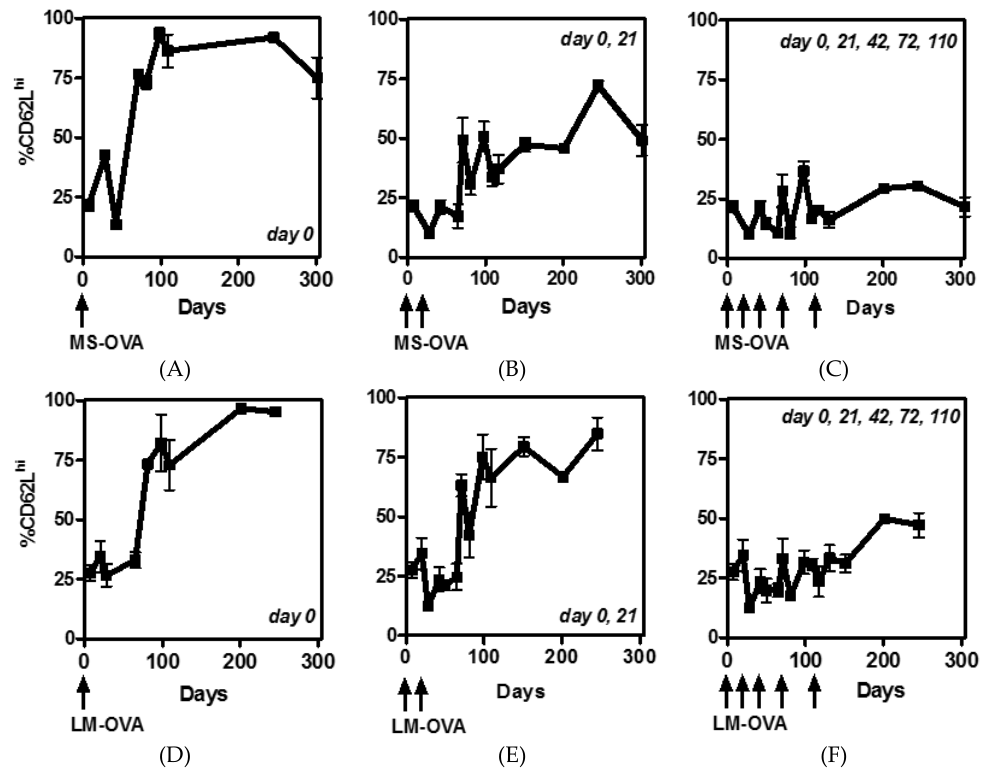
Figure 2. CD62L high expression on responding CD8 + T cells following prime-boost vaccinations with MS-OVA or LM-OVA. C56BL/6 mice were vaccinated s.c. with 20 µg of MS-OVA (panels ( A ), ( B ), ( C )) or 10 4 LM-OVA (panels ( D ), ( E ), ( F )) in the middle of the dorsal flank either once, twice or five times (day 0, 21, 42, 72, 110) as indicated at the top of each panel. Blood samples were taken before vaccination, seven days after and 21 days after each vaccination, as well as at later time-points. Blood was stained with anti-CD8 antibody, OVA 257–263 tetramer and anti-CD62L antibody and analyzed by flow cytometry. Percent CD62L was obtained from a gated population on OVA 257–263+ CD8 + T cells. Mean ± SD, n = 3/timepoint.